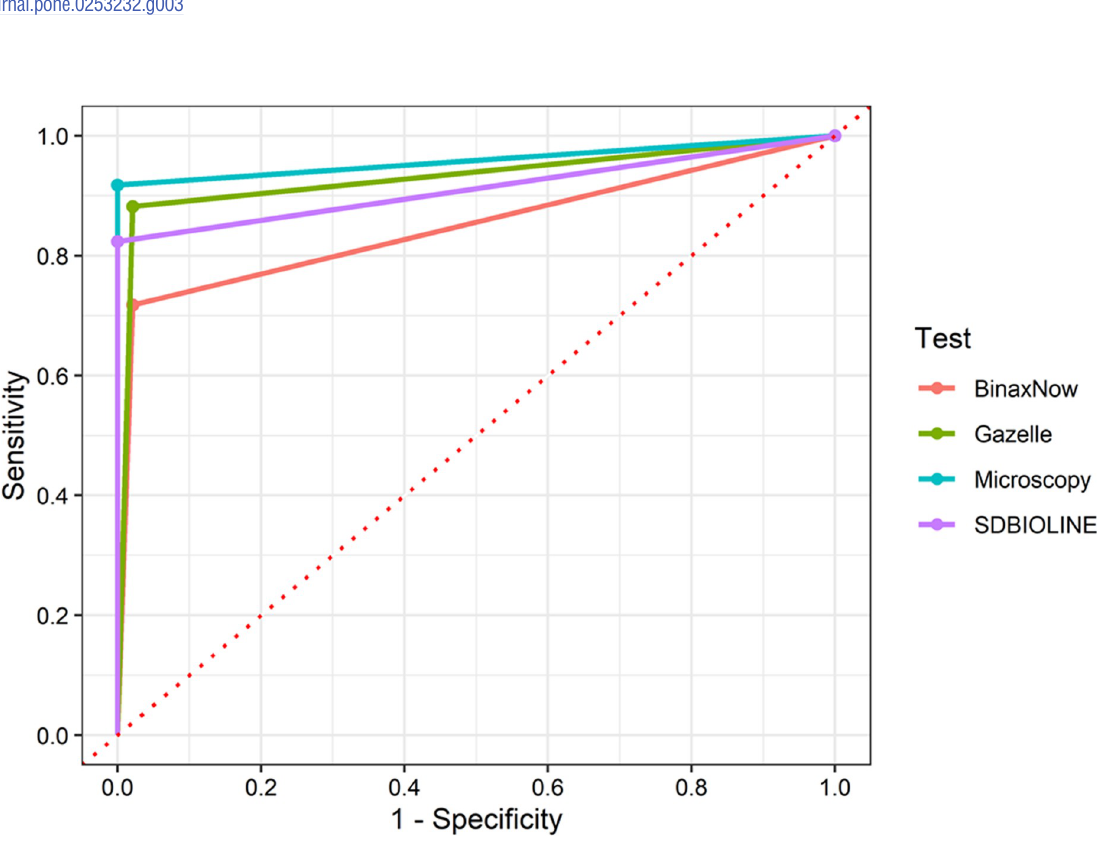
Fig 4. ROC analysis. The figure shows the ROC curves for BinaxNow, SD BIOLINE, microscopy and Gazelle compared with Nested PCR as reference test. Gazelle presented an AUC of 0.93 which is comparable to microscopy with an AUC of 0.96 and higher than BinaxNow (AUC = 0.85) and SD BIOLINE (AUC = 0.91).